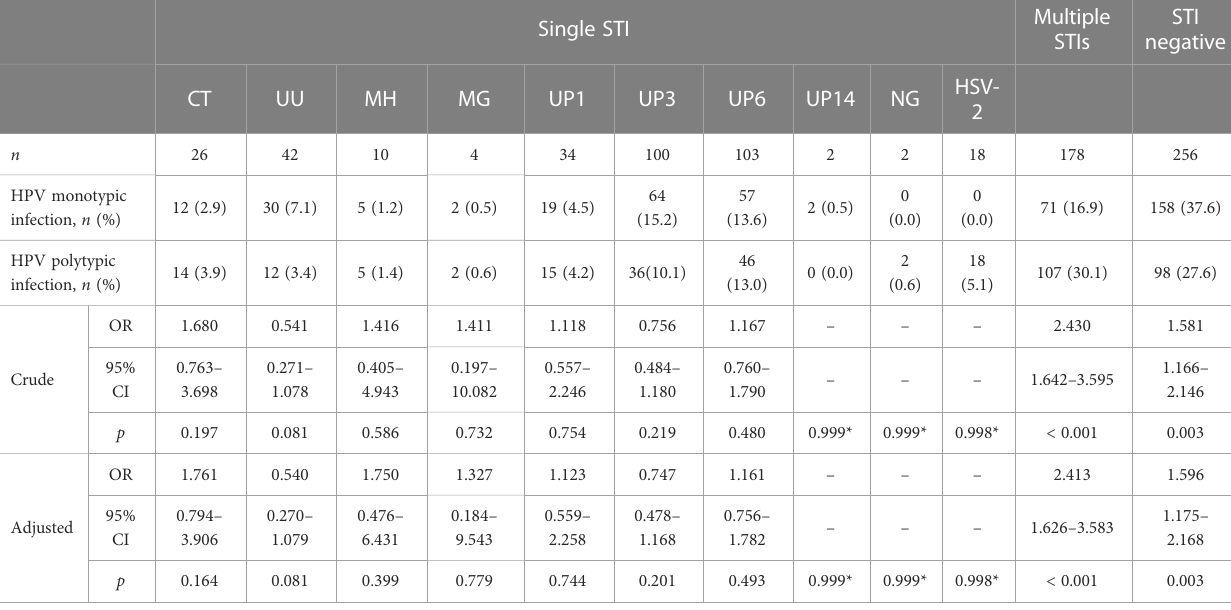
TABLE 4 Infection rates of STIs in groups with monotypic and multiple-type infection of HPV among HPV-positive subjects.